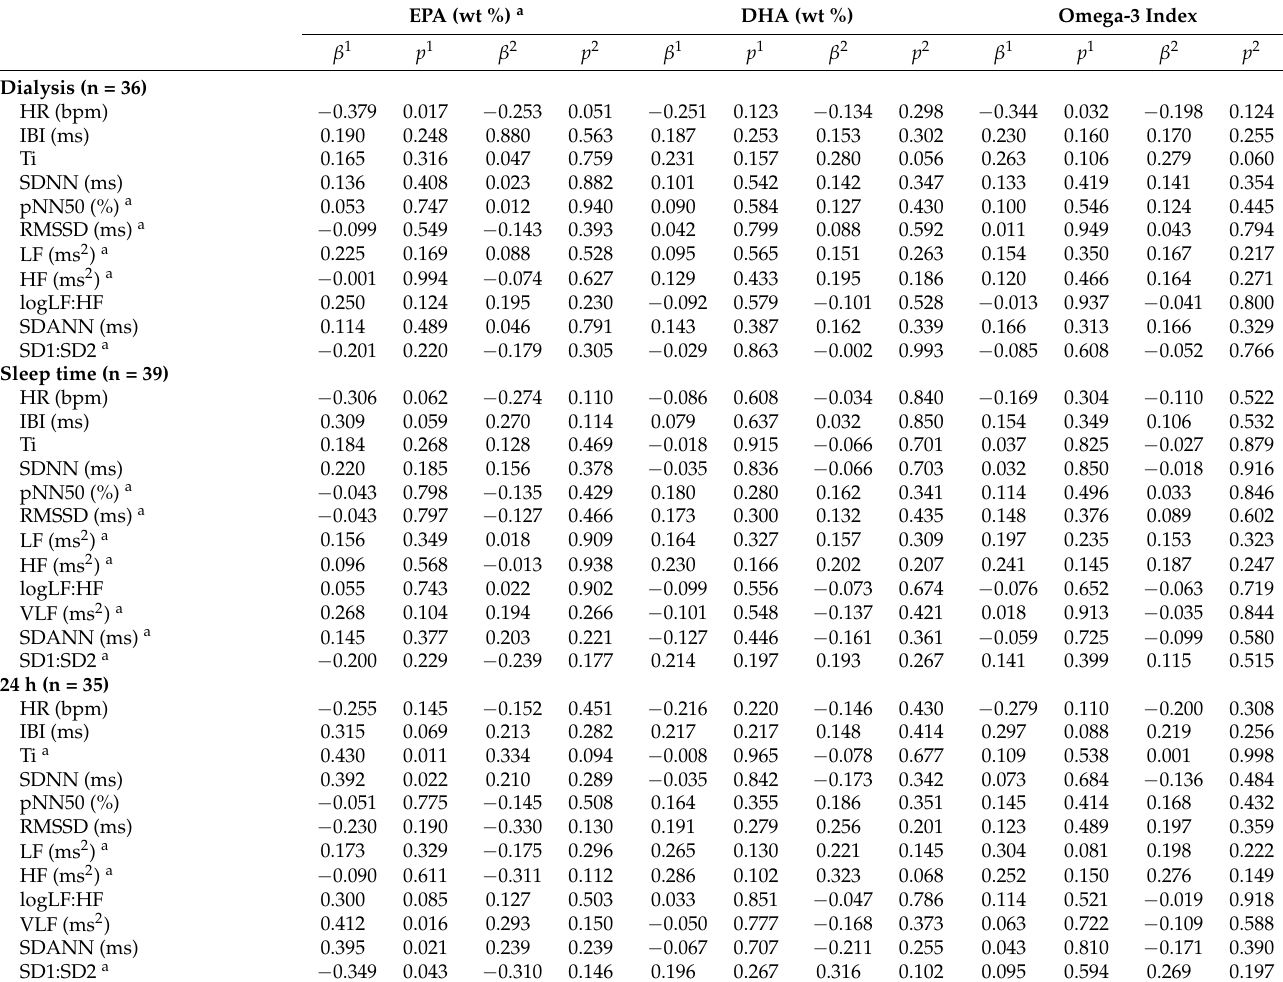
Table 3. Simple and multivariable linear regression analyses between erythrocyte membrane LC n -3 PUFA and HRV during dialysis (2 h), sleep time and over a 24 h